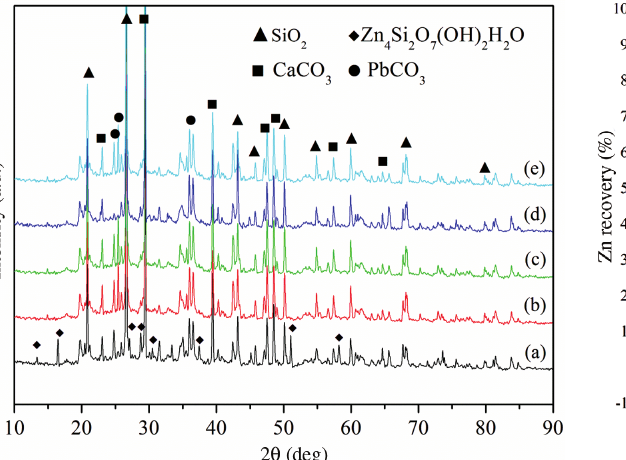
Figure 4: Effect of ammonium citrate (AC) concentration on zinc recovery (average value). Overall leaching rate represents the total leaching rate in the two steps, and first step leaching rate repre- sents the leaching rate in the first step as shown in Figure 2.